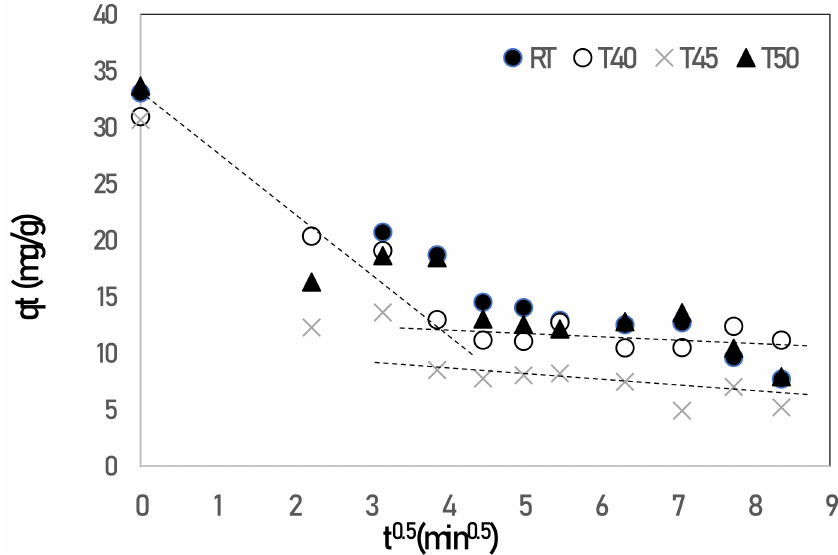
Figure 11. Weber–Morris plots for adsorption at various